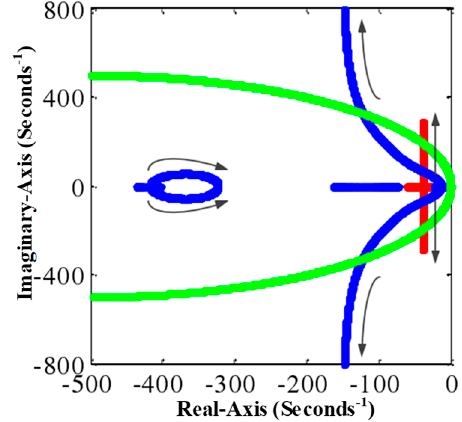
Figure 4. Relationship between pole distribution and stable circle.